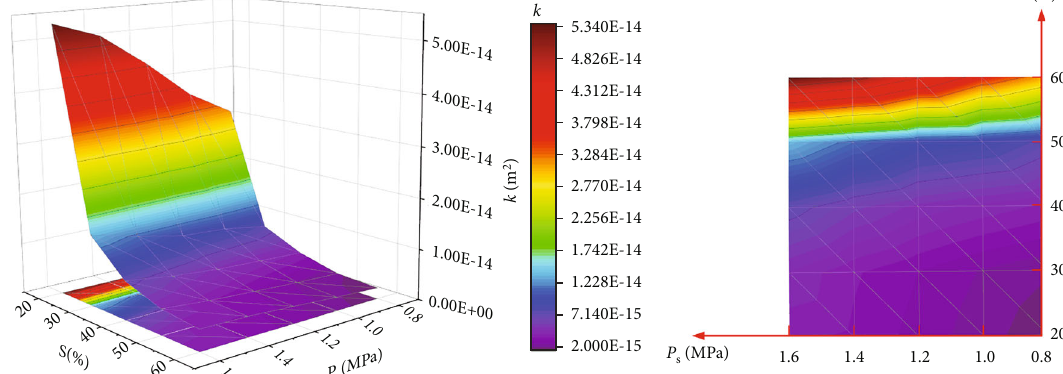
Figure 17: Variation surface of permeability k with osmotic pressure P Table 5: Variation of permeability k with axial pressure P P a (MPa)